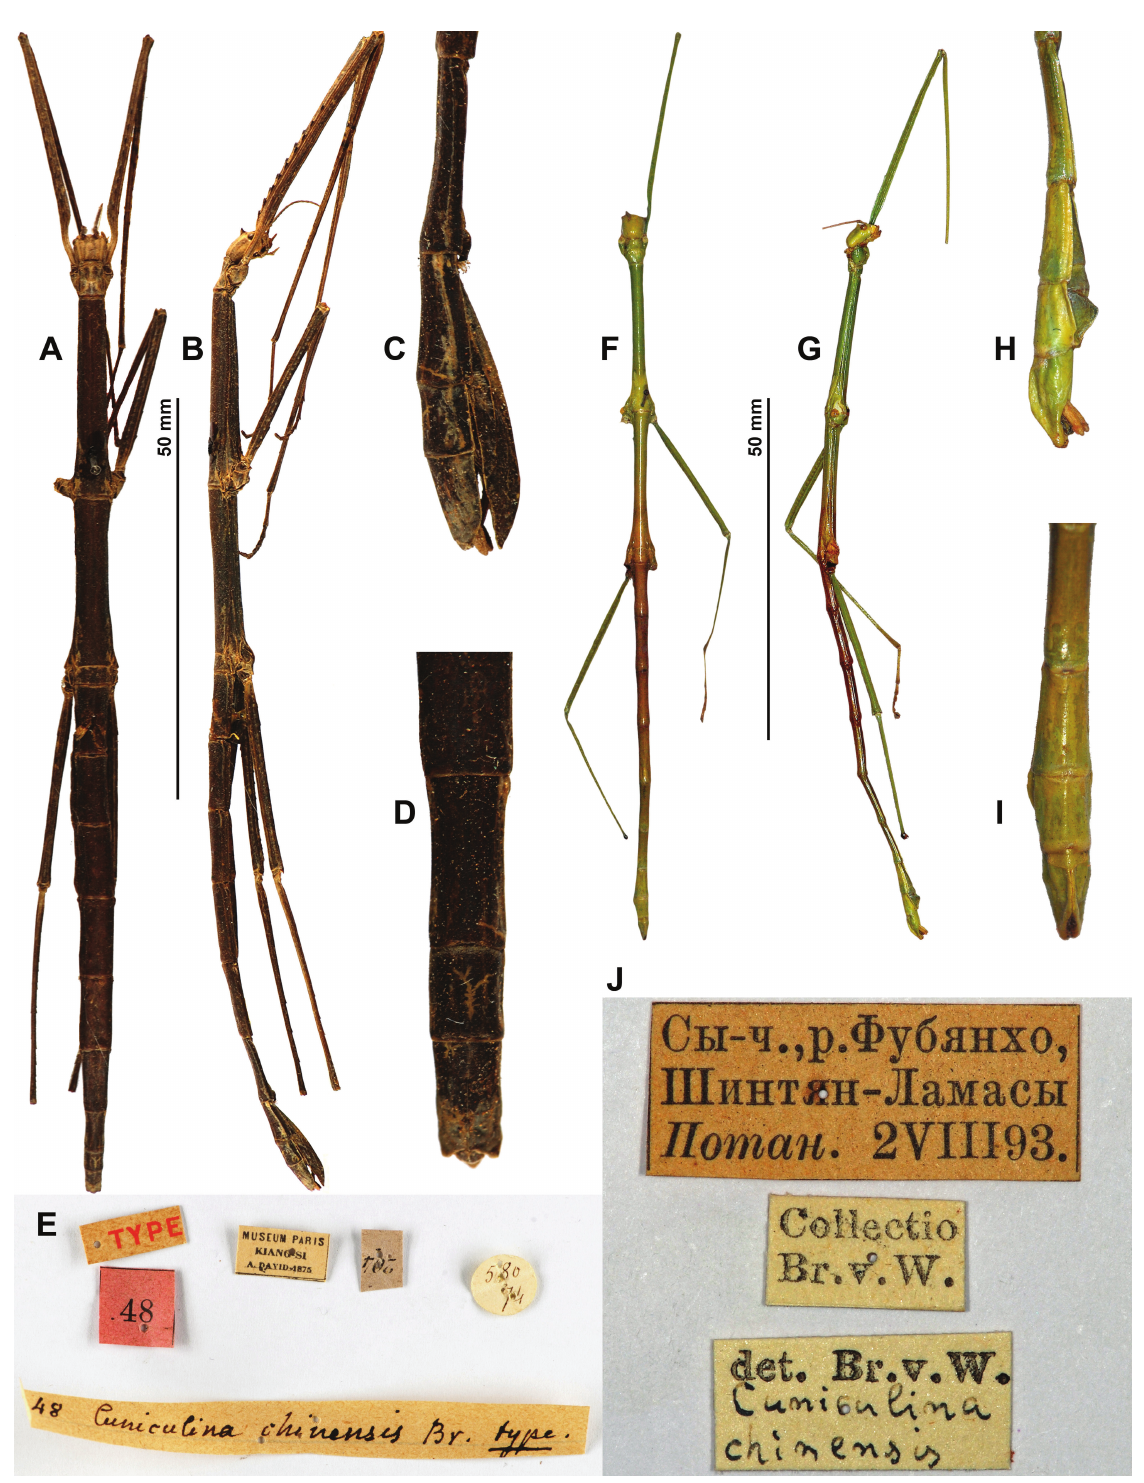
Fig. 1. Baculonistria chinensis (Brunner von Wattenwyl, 1907). — A–E . Paralectotype ♀ (MNHN, photographs by Emmanuel Delfosse). A . Habitus, dorsal view. B . Habitus, lateral view. C . Apex of abdomen, lateral view. D . Apex of abdomen, dorsal view. E . Labels. — F–J .Lectotype ♂ (©Natural History Museum Vienna, Orthoptera Image Collection, published with permission). F . Habitus, dorsal view. G . Habitus, lateral view. H . Apex of abdomen, lateral view. I . Apex of abdomen, dorsal view. J . Labels. C–D, H–I = not to